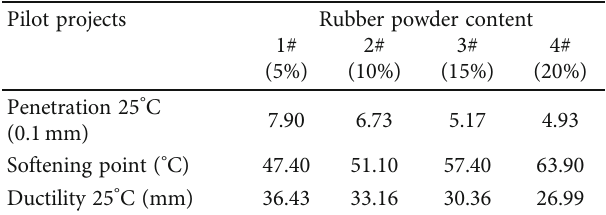
Table 2: Three indexes of 4 kinds of rubber-modi fi ed asphalt. Pilot projects